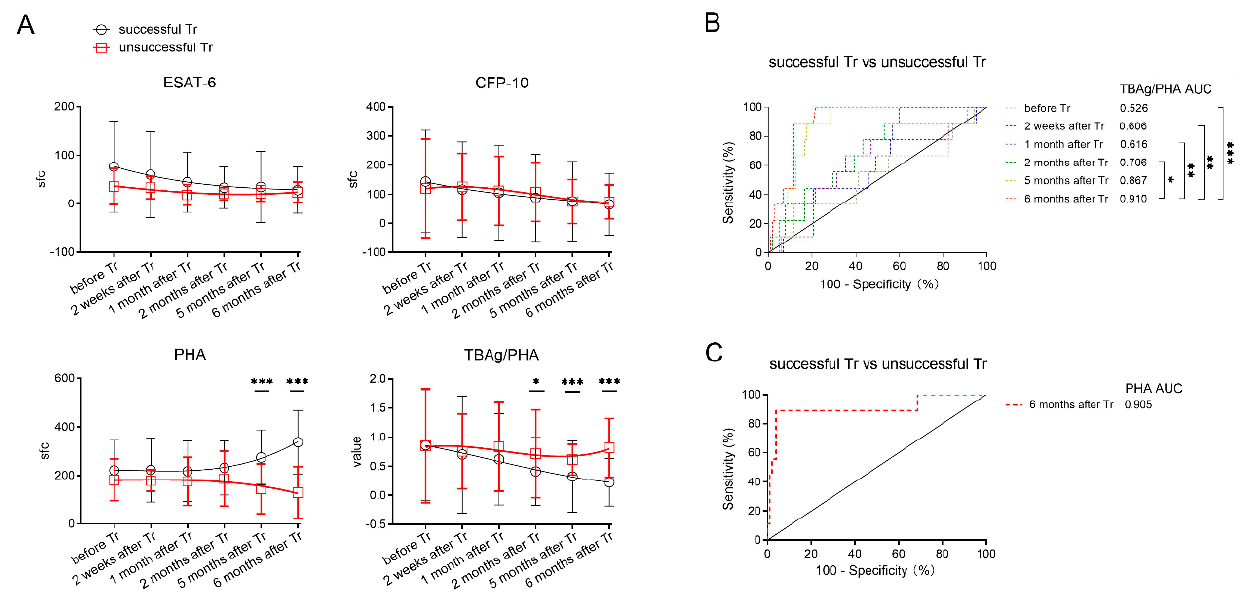
Figure 4. Comparing T-SPOT results between patients with successful and unsuccessful treatment outcomes. ( A ) Dynamic analysis of the T-SPOT results in patients with successful and unsuccessful treatment outcomes. Data in each time point are expressed as mean ± SD (* p < 0.05, *** p < 0.001, between patients with successful and unsuccessful treatment outcomes in each time points). The smoothing cubic splines were fitted to the values of different parameters to summarize the overall trend. ( B ) Receiver operating characteristic analysis was performed for the TBAg/PHA ratio and ( C ) PHA to determine threshold values for distinguishing between patients with successful and unsuccessful treatment outcomes (* p < 0.05, ** p < 0.01, *** p < 0.001). ESAT − 6, early secreted antigenic target 6; CFP − 10, culture filtrate protein 10; PHA, phytohemagglutinin; sfc, spot-forming cells. TBAg/PHA, the ratio of TB-specific antigen to phytohemagglutinin; Tr, treatment.